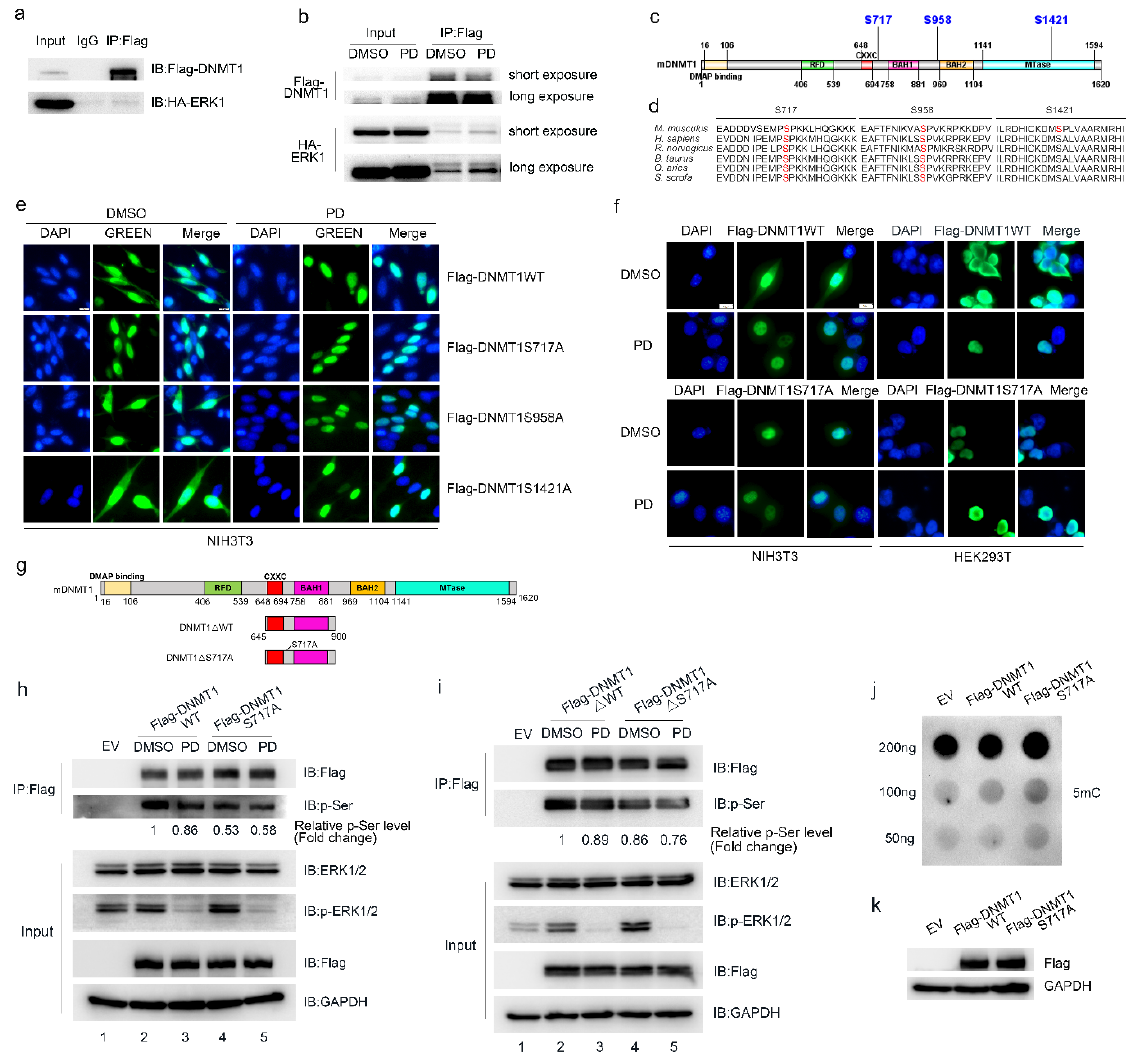
Figure 4. Phosphorylation of DNMT1 at S717 by ERK regulates the subcellular localization of DNMT1. ( a , b ) ERK1 interacts weakly with DNMT1 in HEK293T cells. PD treatment enhances the interaction between ERK and DNMT1. Here, HEK293T cells were co-transfected with p3×Flag- CMV-10-DNMT1 and pCMV-HA-ERK1, and the Flag-DNMT1 fusion protein was captured by an anti-Flag antibody. Mouse IgG was used as a negative control. A Western blot was used to visualize the expression of DNMT1 and ERK1 by measuring fluorescent signals linked to anti-Flag and anti- HA antibodies, respectively. ( c ) Schematic diagram of mouse DNMT1 protein domains and poten- tial ERK phosphorylation targets as predicted by GPS5.0 software. ( d ) Evolutionary conservation comparison of sequences near the S717, S958, and S1421 residues of the DNMT1 protein from dif- ferent species. ( e ) Subcellular localization of wild-type DNMT1 (DNMT1WT) and the DNMT1S717A, DNMT1S958A, and DNMT1S1421A mutant proteins in NIH3T3 cells following DMSO and PD treatment. NIH3T3 cells were transfected with p3×Flag-CMV-10-DNMT1WT, p3×Flag-CMV-10-DNMT1S717A, p3×Flag-CMV-10-DNMT1S958A, and p3×Flag-CMV-10- DNMT1S1421A for 24h. Transfected cells were then treated with 1 μ M PD for 12 h, after which immunofluorescence staining was performed. ( f ) Subcellular localization of wild-type DNMT1 and DNMT1S717A mutant protein following DMSO and PD treatment in NIH3T3 and HEK293T cells. NIH3T3 and HEK293T cells were transfected with p3×Flag-CMV-10-DNMT1WT and p3×Flag- CMV-10-DNMT1S717A for 24 h, respectively. Transfected cells were then treated with 1 μ M PD for 12 h, after which immunofluorescence staining was performed. ( g ) Schematic diagram of the do- mains of truncated DNMT1WT and DNMT1S717A. ( h , i ) The levels of overall serine phosphoryla- tion after DMSO and PD treatment in HEK293T cells that overexpressed wild-type DNMT1 and DNMT1S717A mutant protein. HEK293T cells were transfected with p3×Flag-CMV-10, p3×Flag-